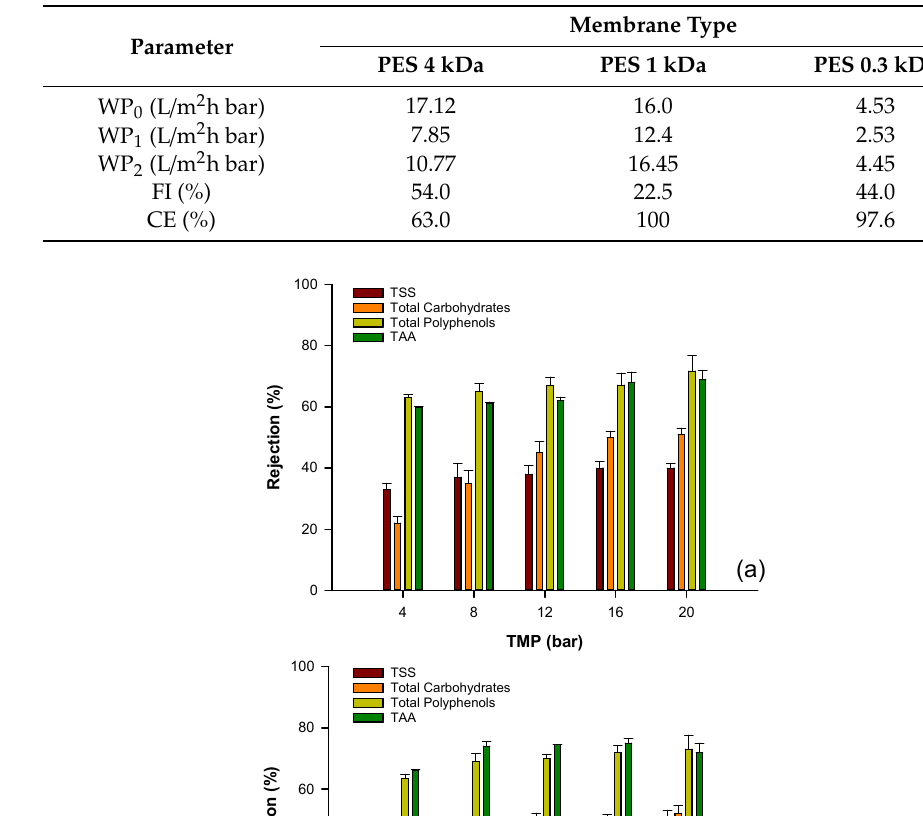
Table 3. Water permeability, fouling index, and cleaning e ffi ciency of UF and NF membranes.